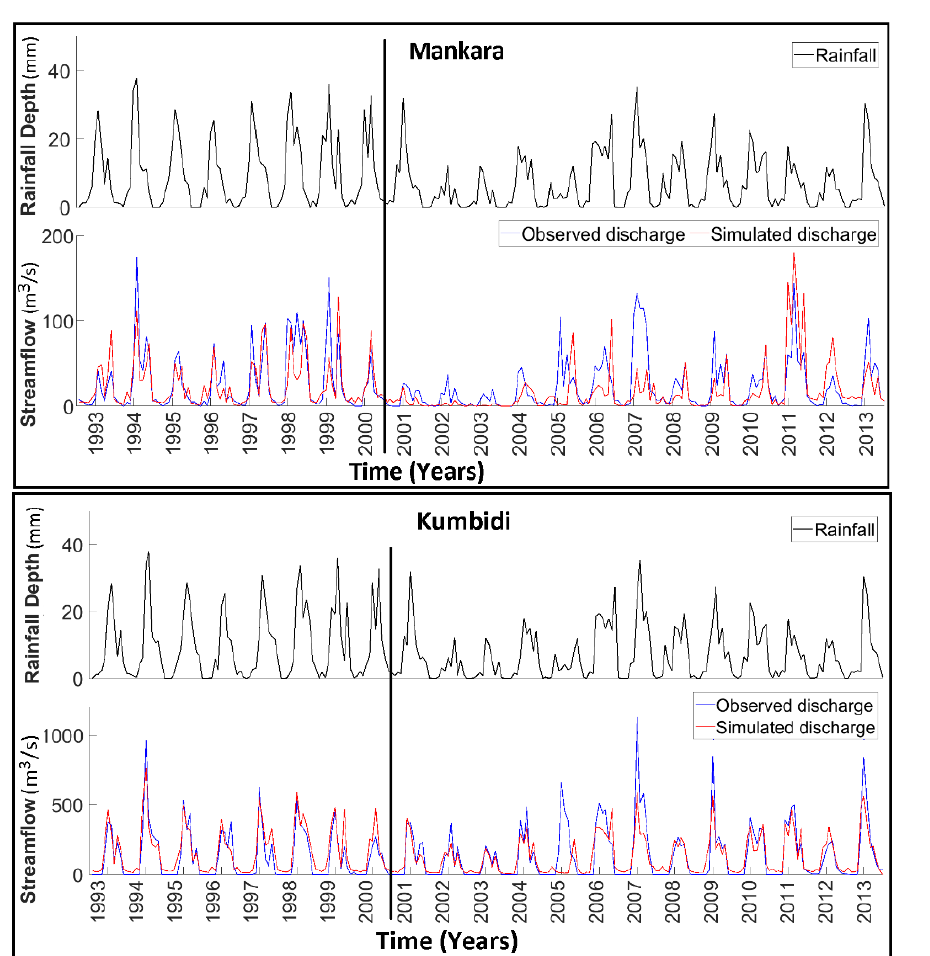
Figure 8. Comparison between the observed and simulated streamflow value during the calibration (1993 – 2000) and Validation (2001 – 2013) period for Mankara ( Top ) and Kumbidi ( Bottom ) gauging stations.